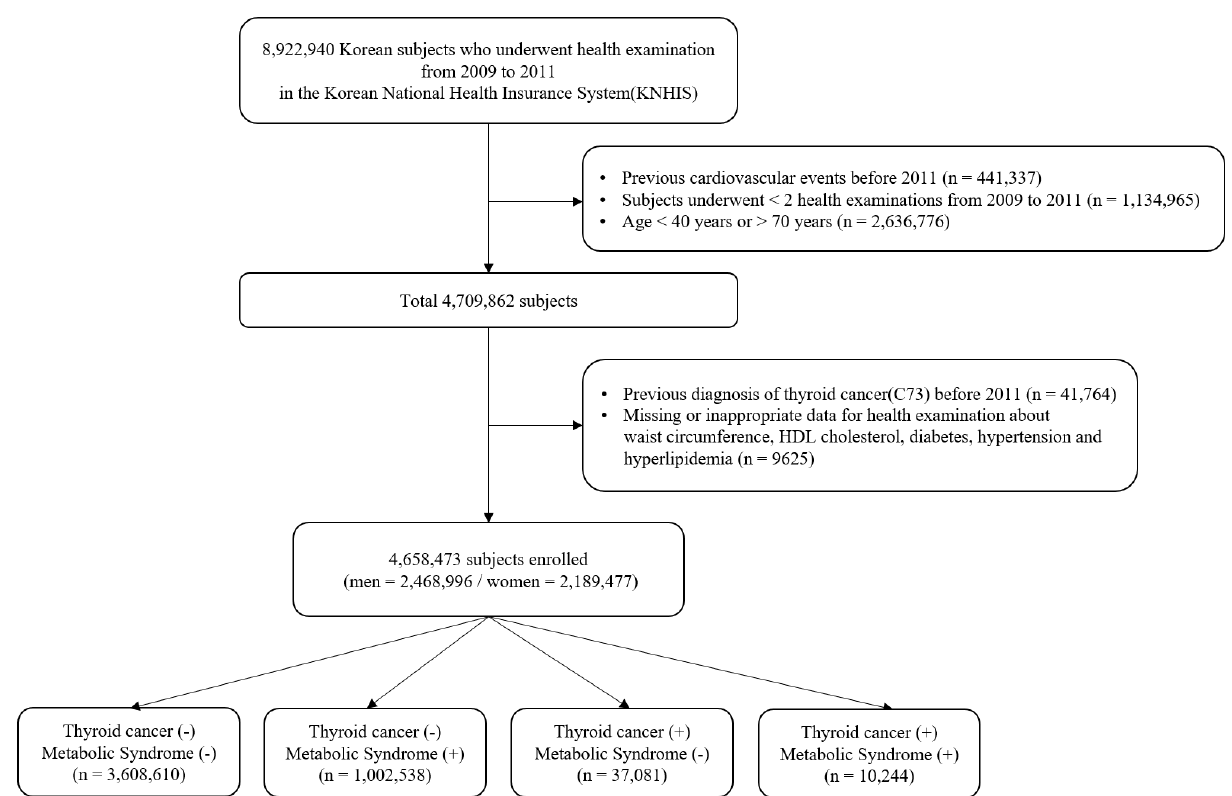
Figure 1. Flowchart of participants’ inclusion and exclusion.